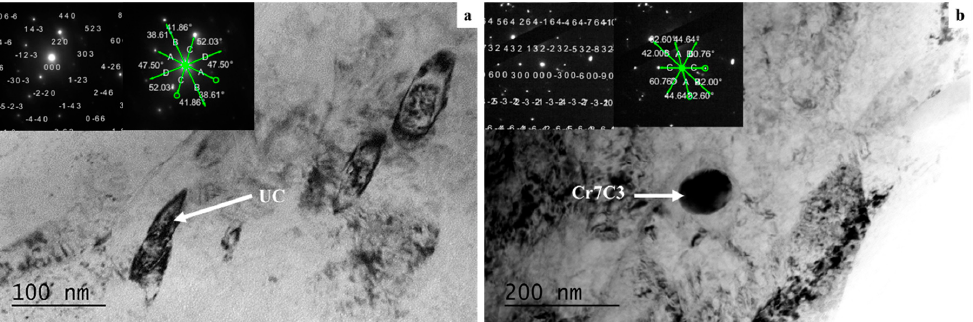
Figure 5. ( a ) Undissolved Cementites (UCs) are present in the final microstructure of the UFH sample. The undissolved cementite indexed pattern is shown on the top left corner ( b ) Undissolved Cr 7 C 3 are present on grain boundaries in the final microstructure of the UFH sample some of these UCs are also found.